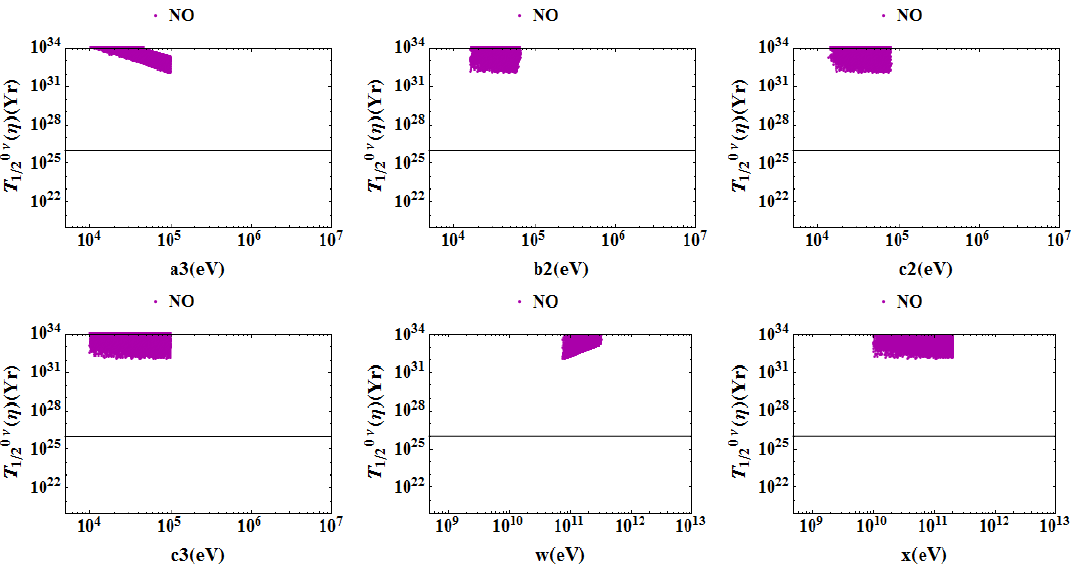
class A1. The horizontal line represents the KamLAND-Zen lower limit.